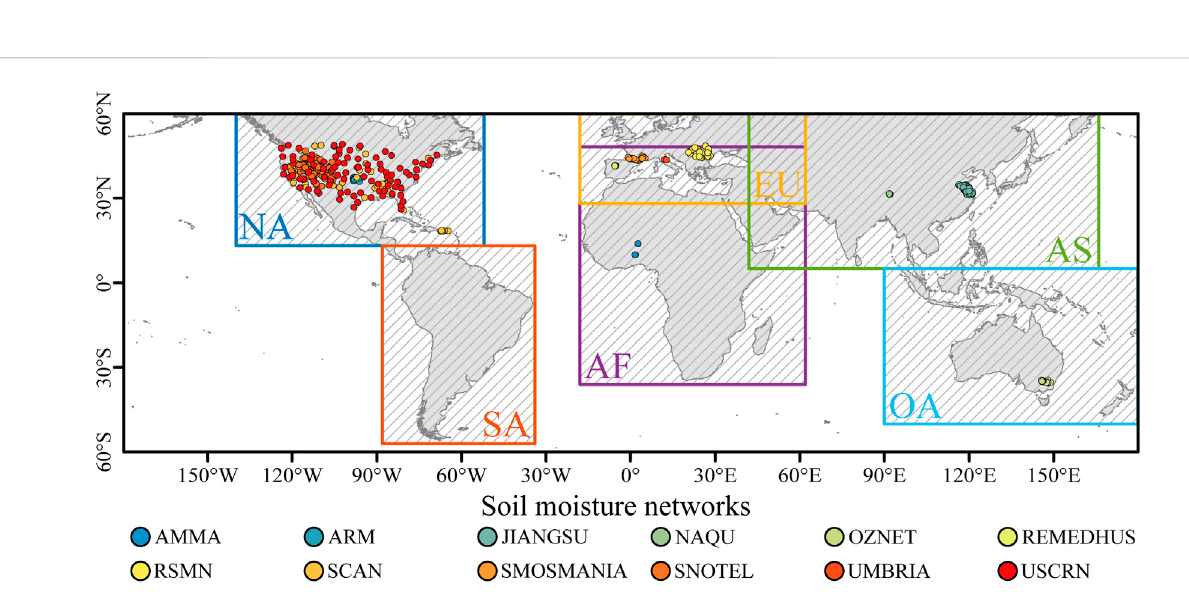
Frontiers in Earth